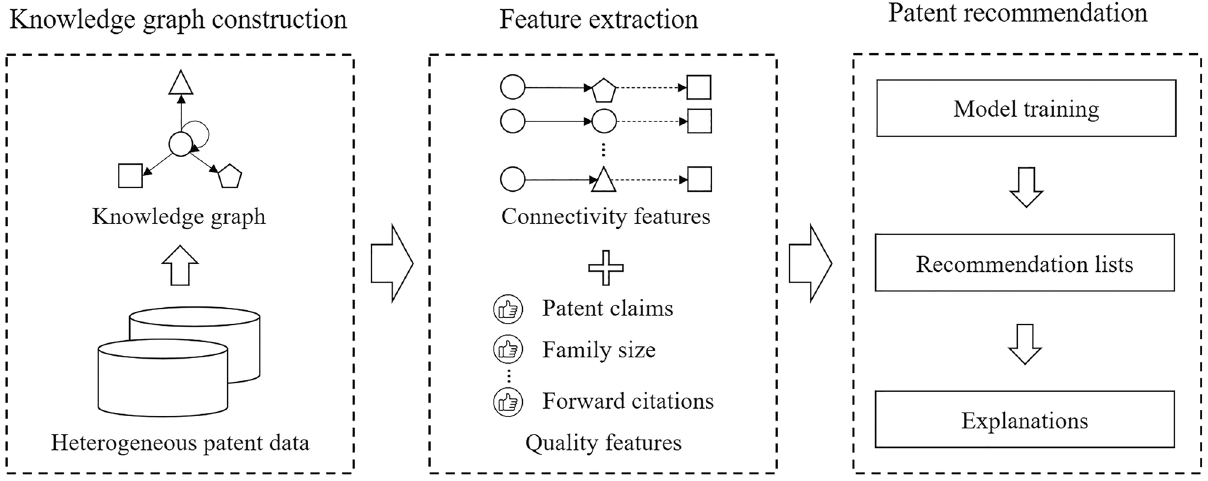
Figure 1. Overview of the proposed patent recommendation